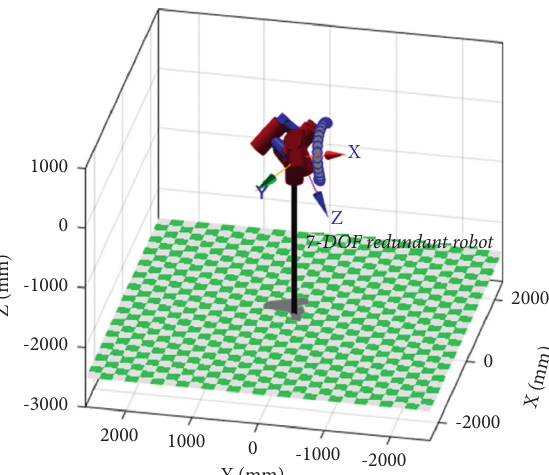
Figure 5: Motion trajectory of the